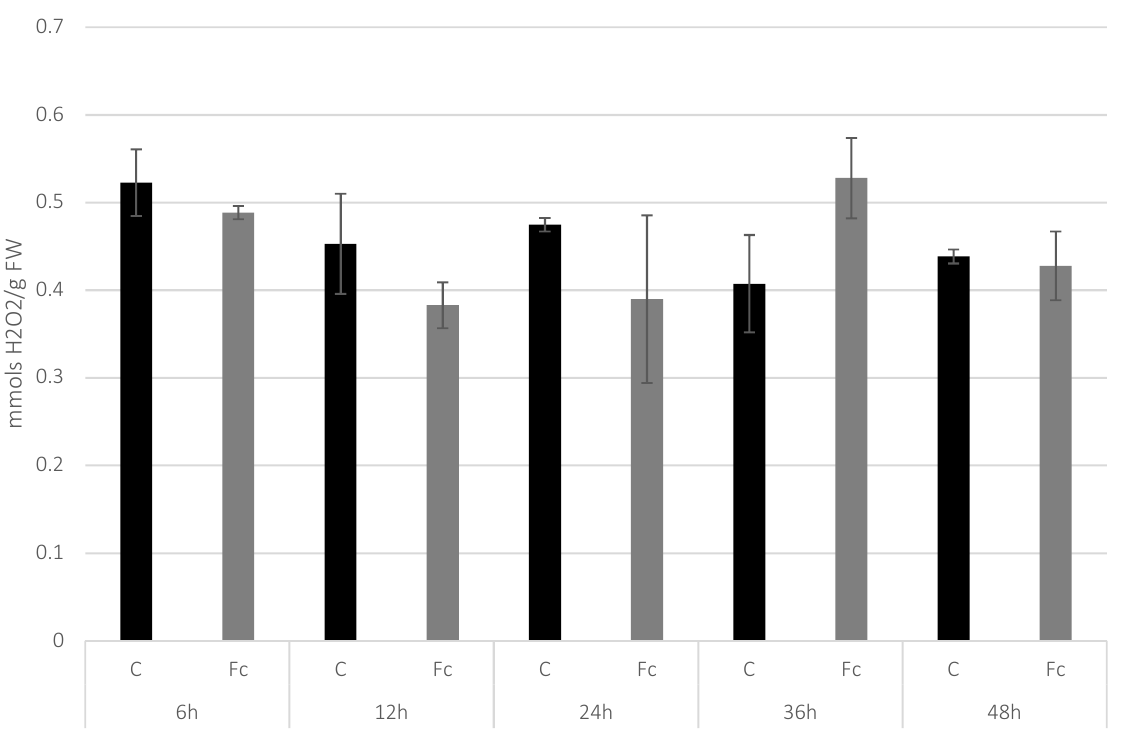
Figure 1. Amounts of H 2 O 2 measured in 14 days old flax seedlings infected with F. culmorum at 6 hpi, 12 hpi, 24 hpi, 36 hpi and 48 hpi. C—untreated control, Fc— Fusarium culmorum treated. Results are presented as means of three biological repeats ± sd.